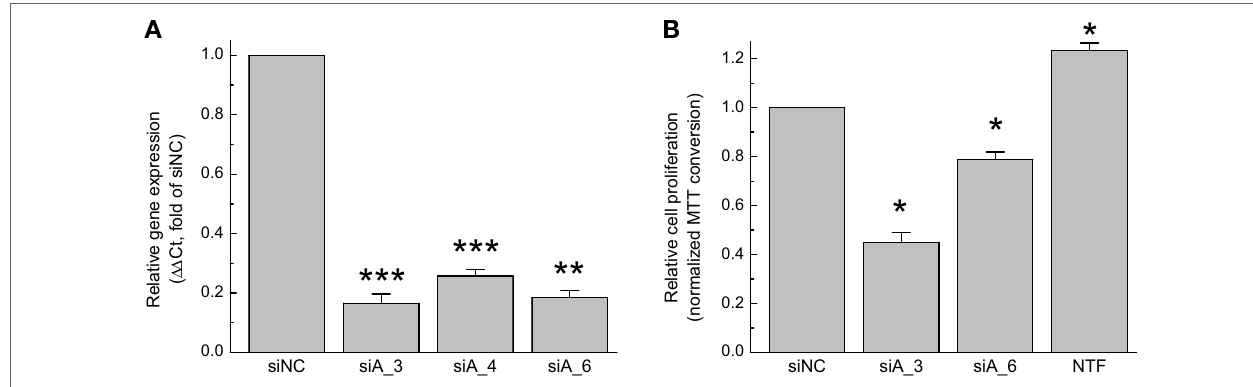
FigUre 1 | Downregulation of leucine-rich repeat-containing 8A (LRRC8A) protein limits proliferation of primary glioblastoma (GBM) cells. (a) Validation of siRNA constructs. GBM cells were transfected with three gene-specific siRNA constructs, siLRRC8A_3 (siA_3), siLRRC8A_4 (siA_4), or siLRRC8A_6 (siA_6). Changes in the LRRC8A mRNA expression levels were quantified 48 h post-transfection and normalized to the expression levels of the housekeeping gene RPL13a in the same samples. The data are the mean values ± SE of four independent experiments performed in triplicates ( n = 4). ** p < 0.01, *** p < 0.001 vs. cells transfected with negative control siRNA (siNC). (B) Effect of gene-specific LRRC8A siRNA on proliferation of GBM cells. Cells were transfected with LRRC8A siRNA (siA_3 or siA_6), or siNC. Relative proliferation rates were determined 96 h post-transfection using a 3-(4,5-dimethylthiazol-2-yl)-2,5-diphenyl tetrazolium bromide (MTT) assay, and further normalized to siNC values within the same experiment. Non-transfected cells (NTF) were used as an additional internal control. The data are the mean values ± SE of three independent experiments performed in triplicates ( n = 3). * p < 0.05 vs. cells transfected siNC.